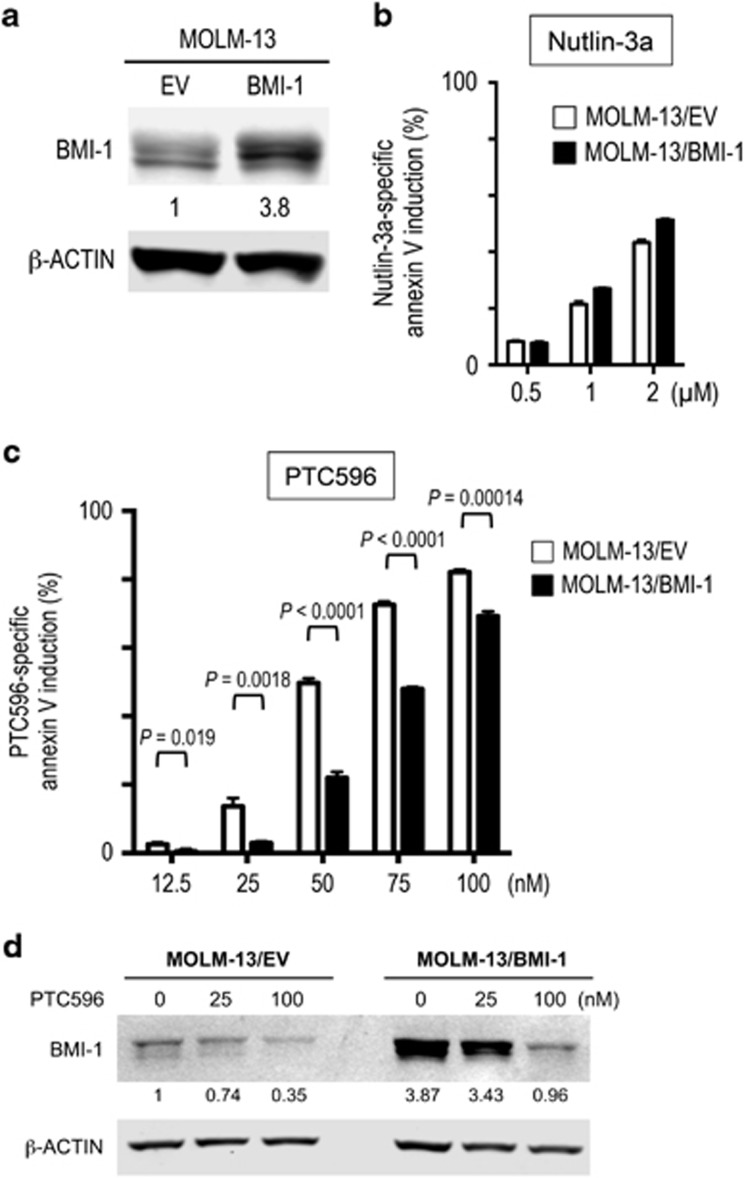
BMI-1 overexpression desensitizes AML cells to PTC596-induced apoptosis. (a) Expression of BMI-1 protein in MOLM-13 cells overexpressing BMI-1 (MOLM-13/BMI-1) or empty vector control (MOLM-13/EV). The intensities of immunoblot signals were quantified and normalized to β-ACTIN. Levels in MOLM-13/EV cells were set at 1.0. (b, c) MOLM-13/BMI-1 and MOLM-13/EV cells were incubated with the indicated concentrations of Nutlin-3a (b) or PTC596 (c) for 48 h, and annexin V-positive fractions were measured by flow cytometry. The results are expressed as the mean±s.d. of triplicate measurements. (d) MOLM-13/BMI-1 and MOLM-13/EV cells were incubated with the indicated concentrations of PTC596 for 48 h, and expression of BMI-1 protein was determined. The intensities of immunoblot signals were quantified and normalized to those of β-ACTIN. Levels in untreated MOLM-13/EV cells were set at 1.0.